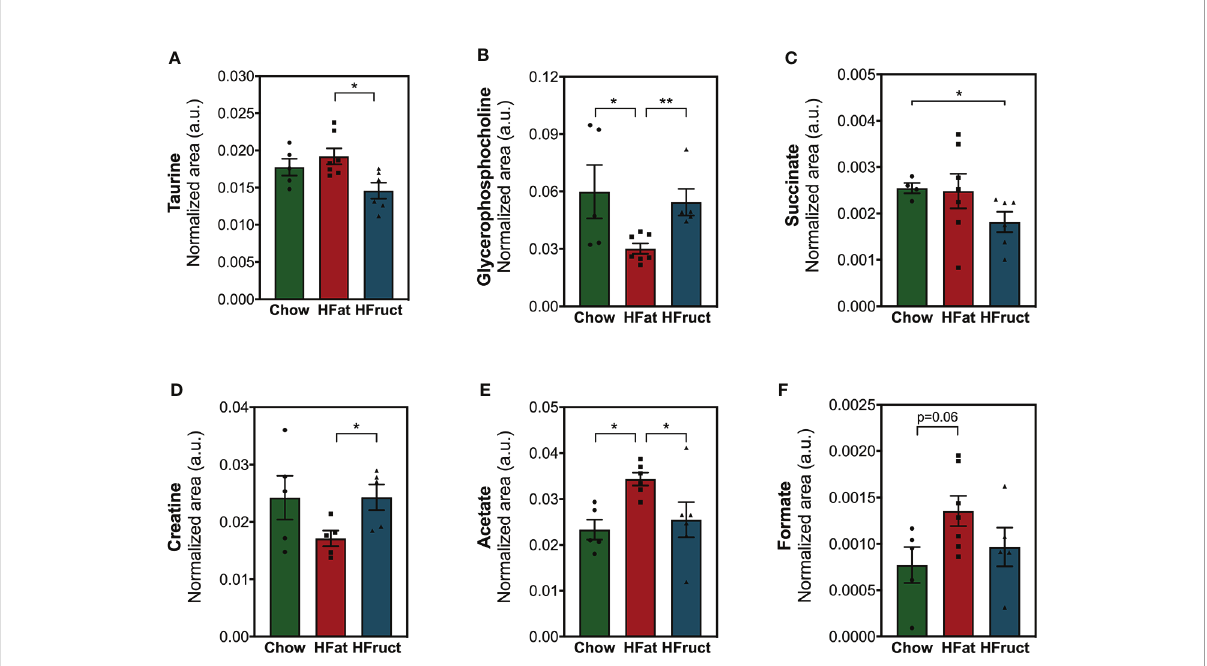
FIGURE 4 Effects of the HFat and HFruct diets on the epididymal white adipose tissue (WAT) metabolism of C57Bl/6J male mice. (A) Taurine; (B) glycerophosphocholine; (C) succinate; (D) creatine; (E) acetate; (F) formate relative areas in WAT after 12 weeks of normal chow (Chow), high-fat (HFat), or high-fructose (HFruct) feeding. Data are presented as mean ± SEM for four to seven mice. *p<0.05,